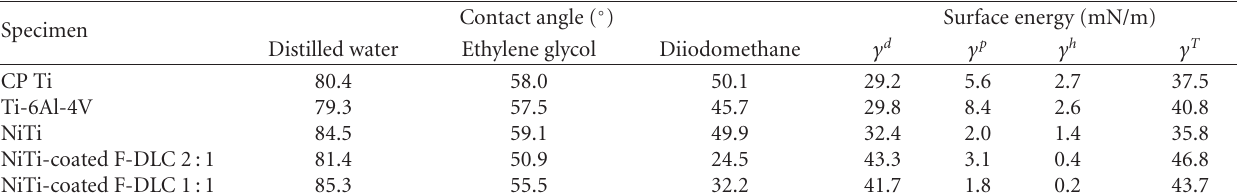
Table 3: Contact angle and surface energy of uncoated compared with coated specimens. Contact angle ( ◦ ) Surface energy (mN/m) Specimen Distilled water Ethylene glycol CP Ti